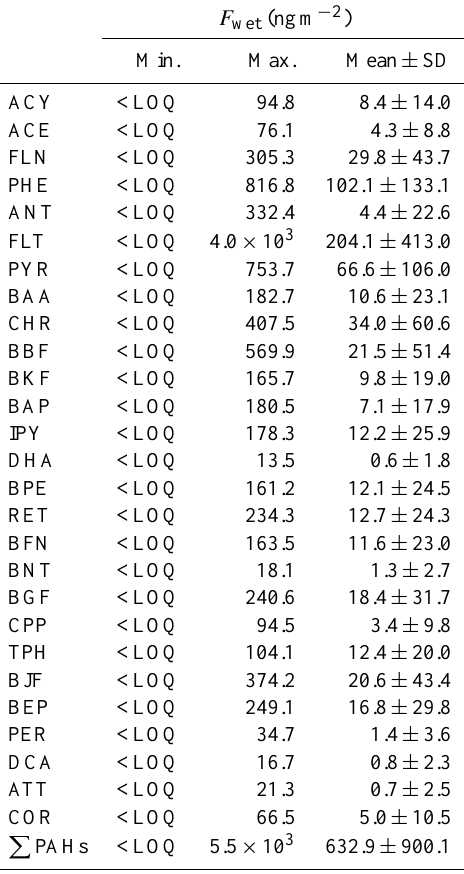
Table 4. PAH daily wet deposition fluxes ( F wet )